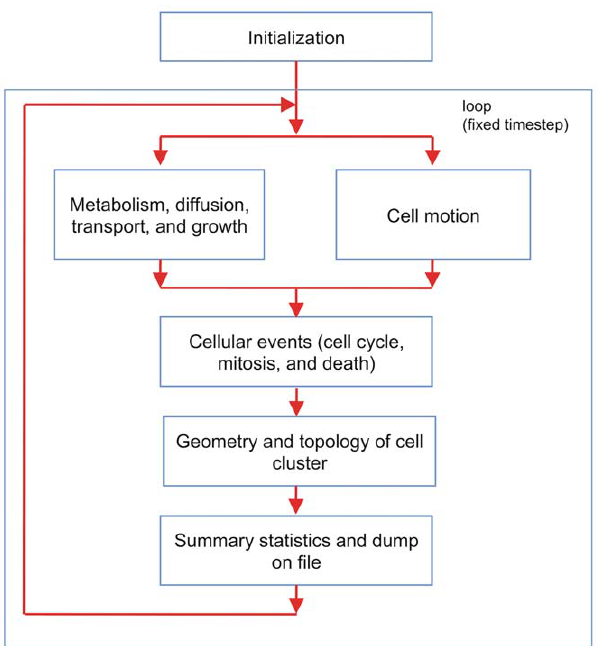
Figure 8. Two views of the microstructure of a simulated spheroid, with about 500 m m diameter and 296264 cells (183893 live cells + 112371 dead cells). (Left panel): flow of extracellular glucose along a central section of the tumor spheroid (yellow arrows) superposed on the plot of glucose concentration. The length of the arrows is proportional to the glucose flow intensity projected on the plane of the section. At this stage, the necrotic core is contractingasdeadcellsgraduallyshrink,andthisleadstoaslowoutwardflowoftheglucosestoredintheextracellularspacesinthiscentralregion.Weobserve that such a behavior depends on the effective diffusion coefficient of glucose, and it disappears completely when the diffusion coefficient is high enough. This also suggests that the flow of glucose and other substances, like therapeutic drugs, is strongly dependent on the biochemistry and structure of extracellular spaces, and even small changes can lead to markedly different internal spheroid morphologies. (Right panel): individual cell velocities in the simulated spheroid. Thisis thesamecentralsectionasintheleftpanel,andthevelocityvectorsareprojectedontheplaneofthesection.Thelengthofeachvectorisproportionalto the projected speed. The velocities in the viable rim show a coherent outward motion, while the velocities in the necrotic core show a rather orderly inward motion,withsomevortices duetolocalresidualcellproliferation.Theregionin-betweenissomewhatchaoticandtheglobalstructureofthis plotmirrors thatof the glucose flow shown on the left. The supporting information includes higher-quality versions of these figures and those of other flows.